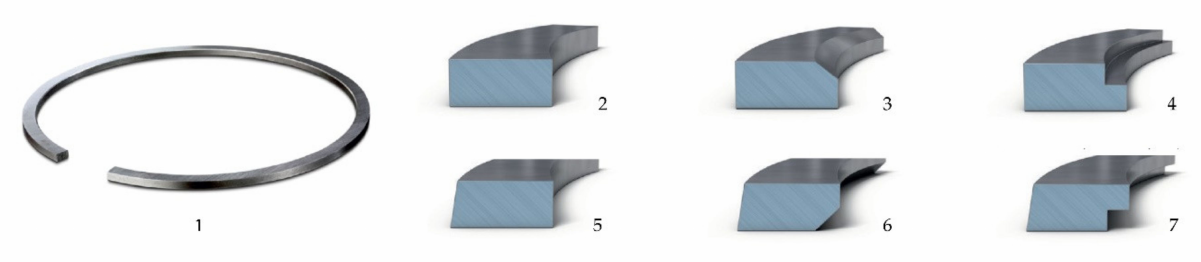
Figure 2. Compression piston rings [38]: 1, 2—Cylindrical compression ring; 3—cylindrical compression ring with internal chamfer; 4—cylindrical compression ring with internal angle; 5—tapered ring; 6—conical ring with lower inner chamfer; 7—conical ring with lower inner